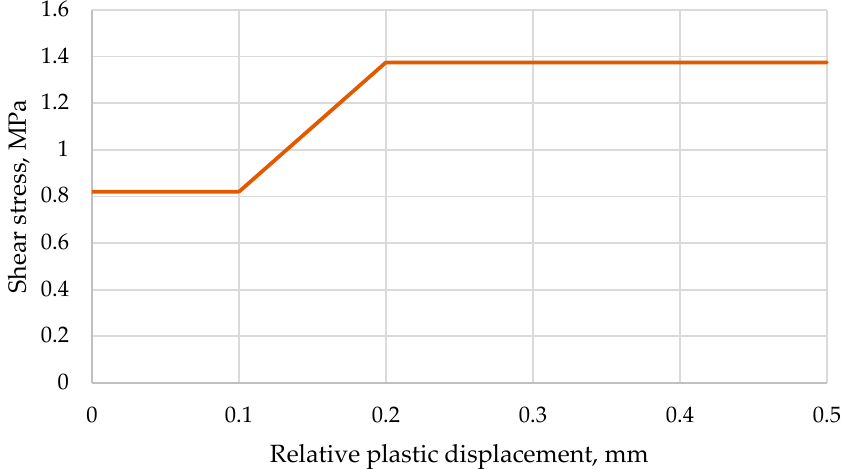
Figure 7. Concrete layer bonding stress curve for specimen S-C65L30-6D8-Ba. Table 1. Concrete characteristics for numerical models.